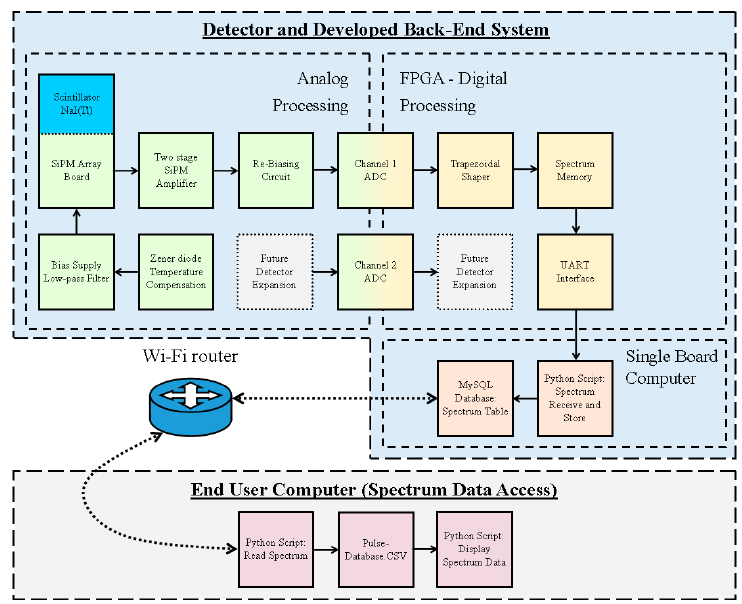
Figure 1. Block diagram of the whole backend system including the digital processing and database access method.